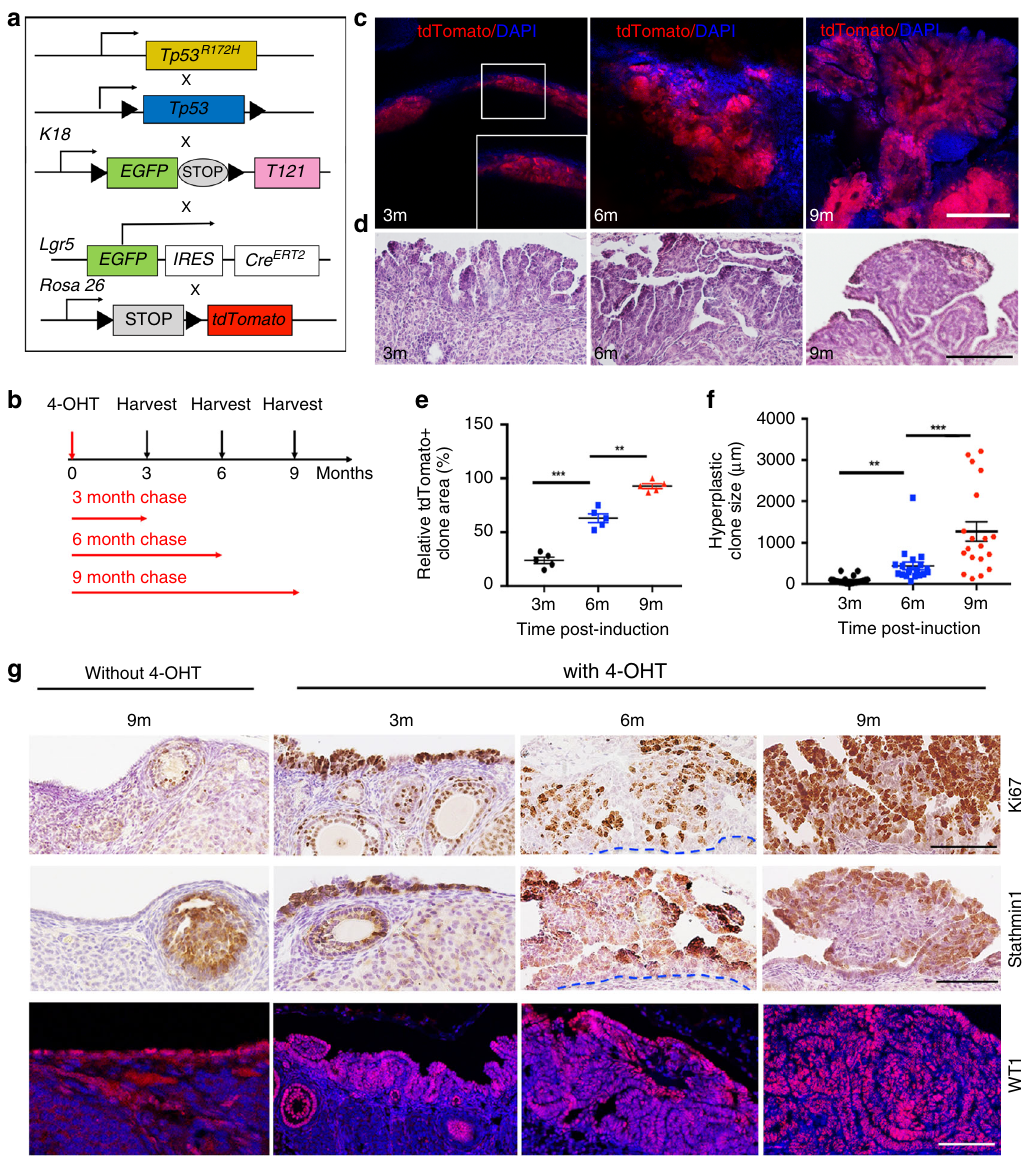
Fig. 5 Lgr5 + cells can initiate tumors with markers of HGSOC. a Schematic depicting crosses of Tp53 R172H/ − ;T121;Lgr5Cre ; and Rosa26-tdTomato mice. b Lineage tracing scheme for Lgr5Cre;Rosa26-Tdtomato mice. c Whole mounts of ovaries from LPT;Rosa26-Tdtomato mice induced with 4-OHT at 6 weeks (pulse), followed by sacri fi ce and analysis at the indicated times (chase), showing Tomato (red), and DAPI (blue) fl uorescence; region within the white box in left top panel is magni fi ed below. Note expansion of isolated Tomato + cells into Tomato + clones. Scale bar, 50 μ m. d Corresponding H&E-stained sections from ovaries in c ; e Relative areas of Tomato + OSE clones at the indicated times after 4-OHT induction (chase times); clone size was determined by measuring the longest length of a discrete Tomato + clone. Each circle represents a distinct Tomato + clone, with n = 3 ovaries analyzed/time point, and a total of 180 clones counted (full data are provided as a Source Data fi le). f Quanti fi cation of hyperplastic clone size on the ovarian surface, determined by measuring the longest ‘ length ’ of epithelial protrusions (tumor cells) from the border with stromal cells. For each time point, 20 cross-sections from three ovaries were counted. Data represent mean ± SEM; * P < 0.05, ** P < 0.01, and *** P < 0.001, Tukey ’ s multiple comparison test; Source data are provided as a Source Data fi le. g Representative IHC (Ki67 and Stathmin-1) and immuno fl uorescence (WT-1) staining for HGSOC markers in OSE from LPT mice at the indicated times after 4-OHT induction or without treatment; scale bars: 100 μ independent tumors from FTE-derived PTPT organoids (T-FT) and injected 10 5 each into MFPs (Supplementary Fig. 7b). Again, OSE-derived tumors had a slower growth rate and longer latency ( P < 0.05 at 4 months, P < 0.001 at 5 months, two-way ANOVA, FTE (N-FT) samples (three each) served as controls. FTE (tumor Supplementary Fig. 7c) than their FTE counterparts. and normal) and OSE (tumor and normal) samples segregated by unsupervised clustering (Fig. 7a). Of the 8623 differentially expressed genes (DEGs) in FTE- versus OSE-derived tumors omes of FTE-derived and OSE-derived HGSOC . We used RNA ( P adj < 0.05), 3641(42%) were differentially expressed in cognate sequencing (RNAseq) to explore the molecular basis for the dis- normal tissue (intersection between N-O vs. N-FT, purple ovals, tinct behavior of FTE-derived and OSE-derived HGSOC. Five